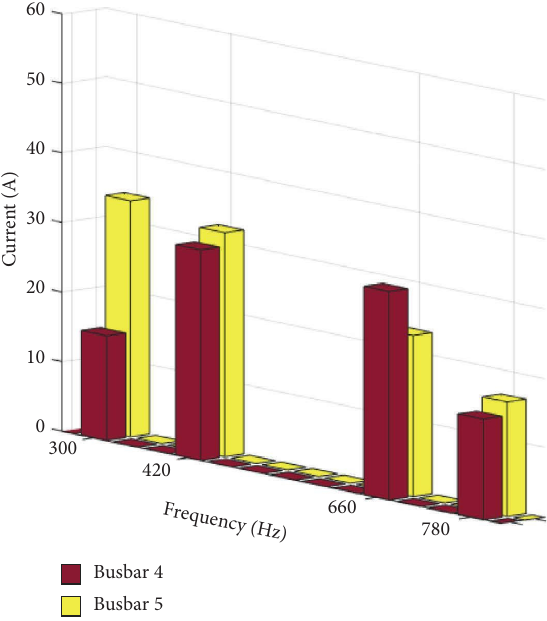
Figure 9: Case 4-Harmonic Current Spectrum in busbars 4 and 5.